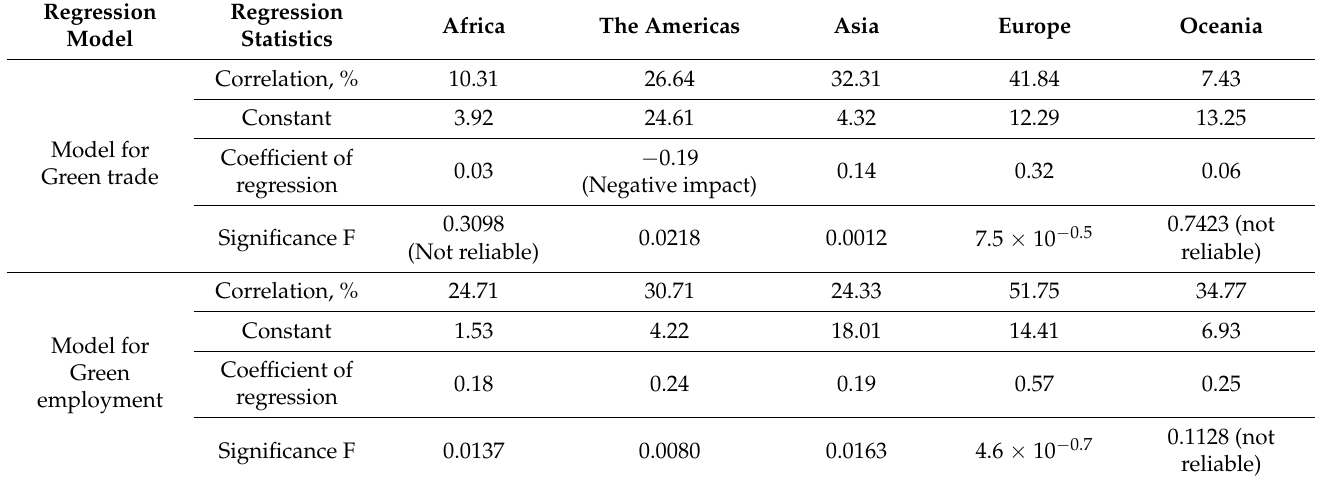
Table 4. Regression dependence of the indicators of the green economy that are subject of the financial risks of the pandemic on (private) green investments in the context of regions of the world in